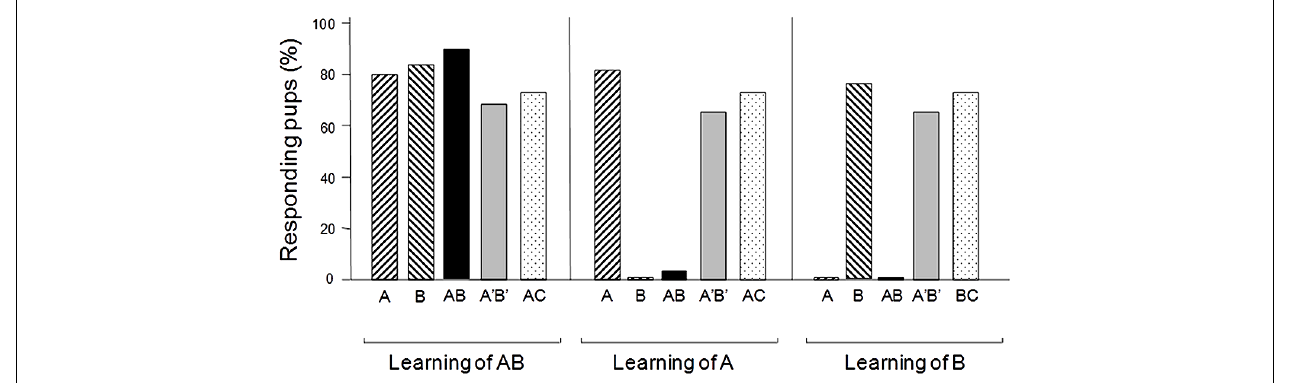
mixtures.Therefore they perceive the elements A and B during the learning episode. However, after conditioning to odorant A or B, they respond to the conditioned odorant but not to the AB mixture; nevertheless, they respond to the A’B’ and AC mixtures.Thus, newborn rabbits perceive the odor of a configuration in the AB mixture in addition to the odors of each odorant, while they perceive only (or mainly) the elements in the A’B’ and AC mixtures (adapted from Coureaud etal., 2008, 2009,